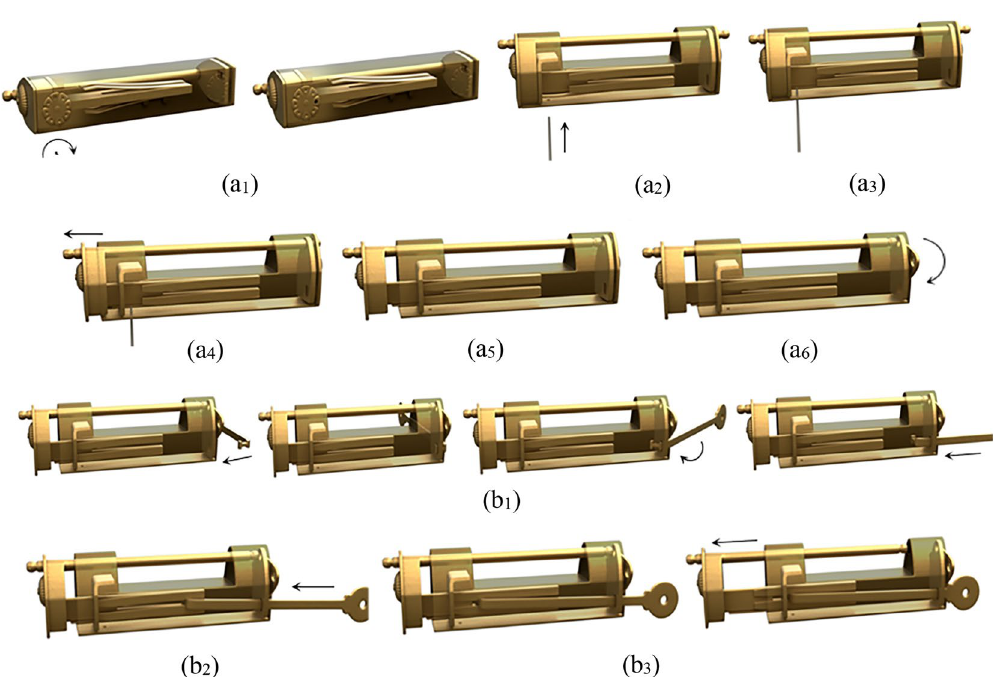
Figure 14. Simulation of rotating ornament